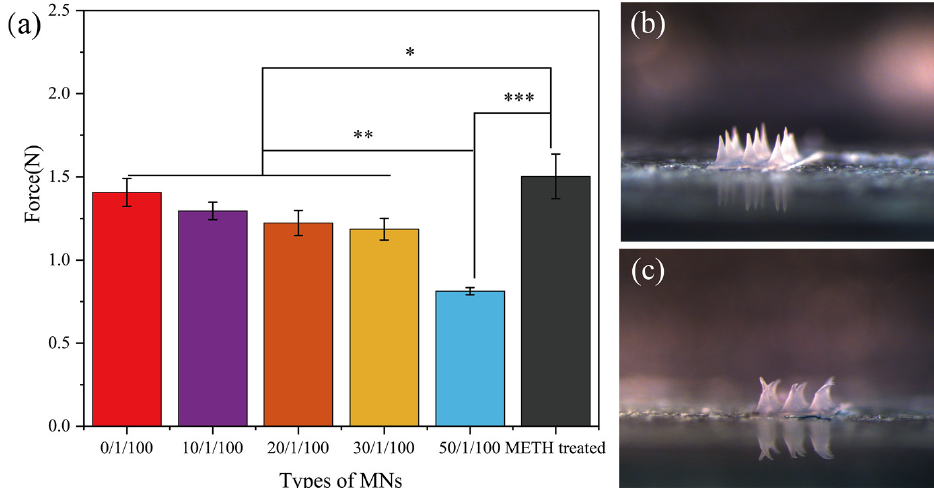
Figure 4. Compression performance test of MT/SF@MNs: ( a ) breaking strength tested by TMS-PRO texture instrument, ( b ) image of MNs image before compression, and ( c ) image of MNs after compression (* p < 0.05, ** p < 0.01, *** p ≤ 0.001).